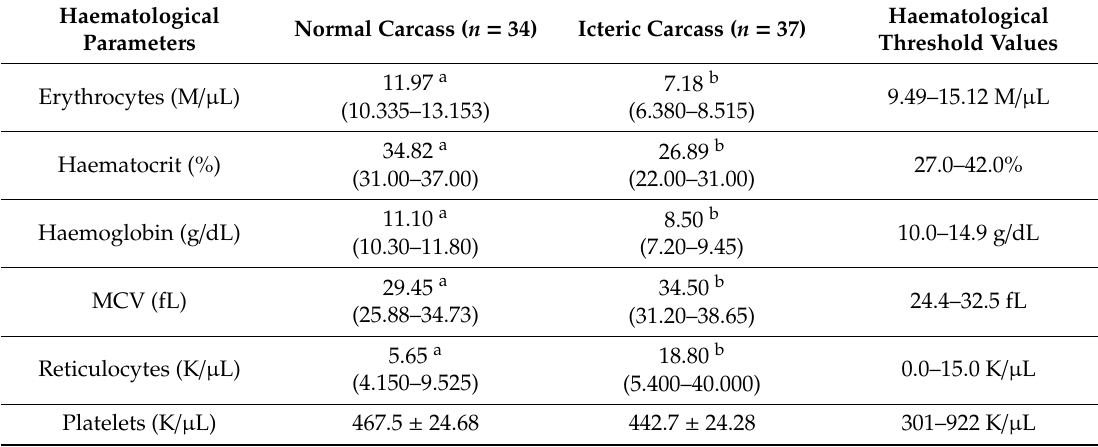
Table 2. Haematological parameters (median value and 25th and 75th percentile values) of lambs that presented icteric carcasses. Mean ± Standard error of